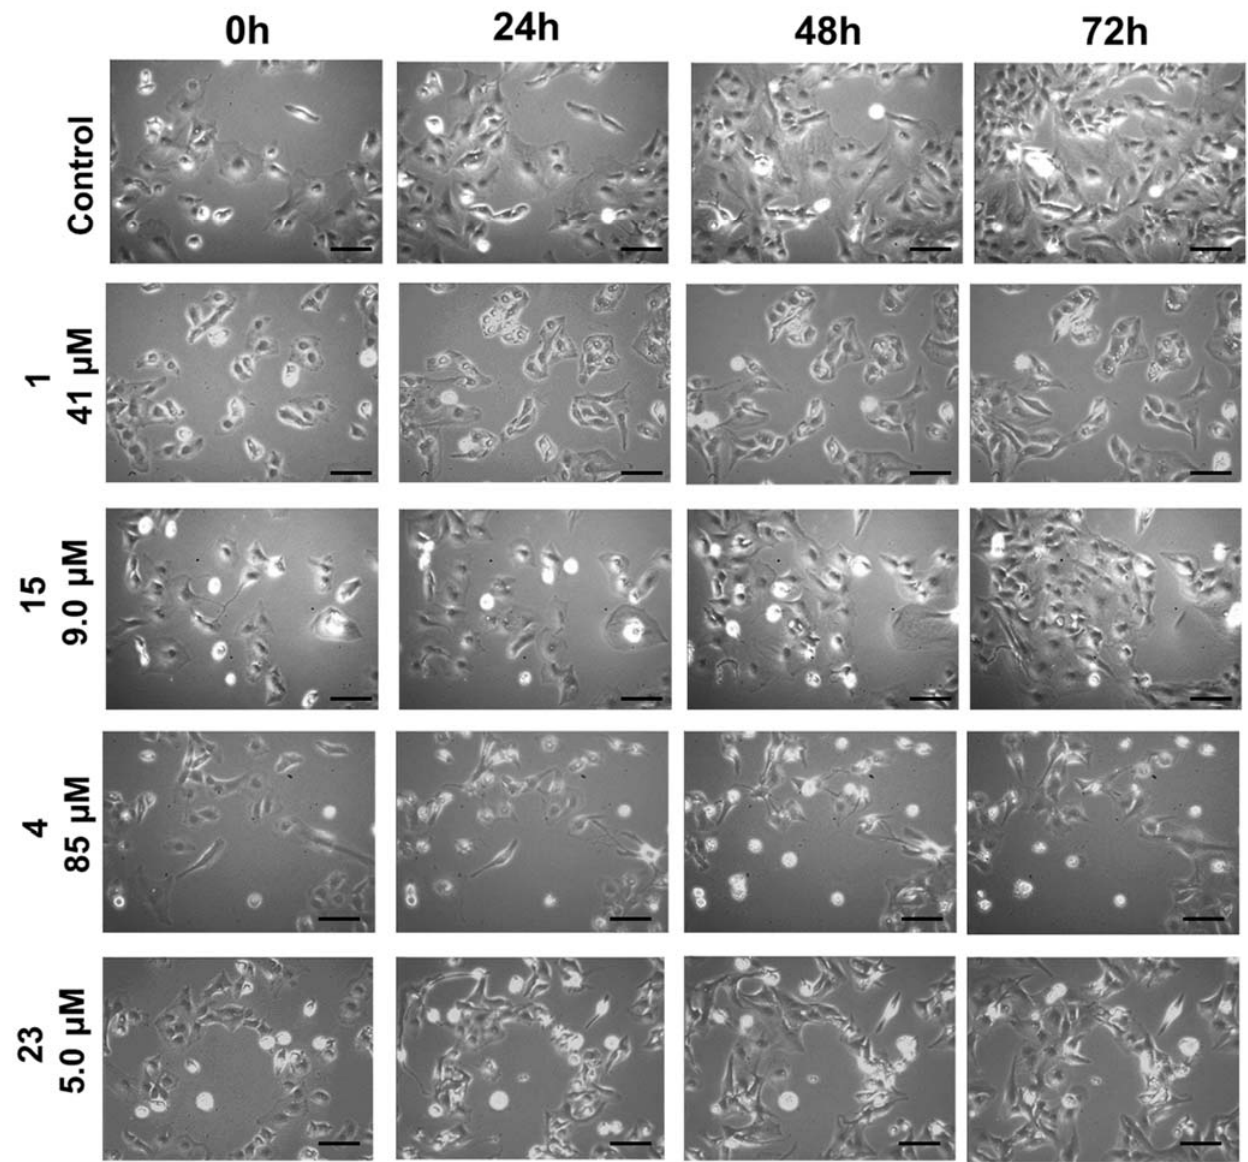
Figure 7. In vitro videomicroscopic analysis of the anticancer effects of monomeric Wittig products 1 and 4 as well as cross-linking agents 15 and 23 . The U373 human glioma cell line was treated with polygodial and ophiobolin A derivatives at their mean GI 50 concentrations (Table 1) or left untreated. The experiment was conducted once in triplicate. Scale bars correspond to 100 μ m.